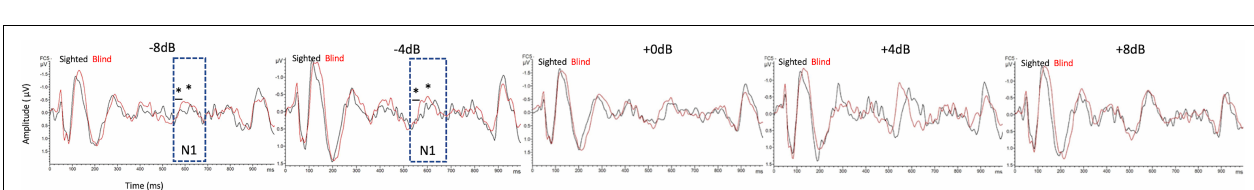
FIGURE 5 | Comparisons of acoustic change complex (ACC) at the FC5 electrode between early-blind subjects and sighted subjects. The N1 peak amplitude originating from/ba/in babble noise was greater in early-blind subjects than in sighted subjects at SNRs -of -8 dB and –4 dB ( p = 0.004 and p = 0.003, respectively, Bonferroni’s corrected α = 0.05/5 = 0.01). The latency of the N1 peak at the FC5 electrode was shorter in the early-blind subjects than in the sighted subjects under an SNR of –8 and –4 dB ( p = 0.007 and p < 0.001 respectively, Bonferroni’s corrected α = 0.05/5 = 0.01). ∗ Significant in the N1 peak amplitude; ∗ Significant in the peak